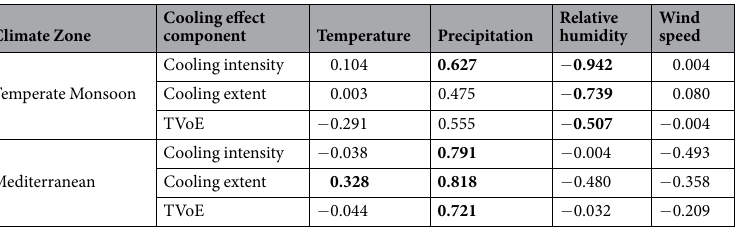
Table 5. The relationships between the cooling effect of Grass-covered UGV and the temperature, precipitation, relative humidity. The p-value test was not applied in this section due to the limited sample size (n =